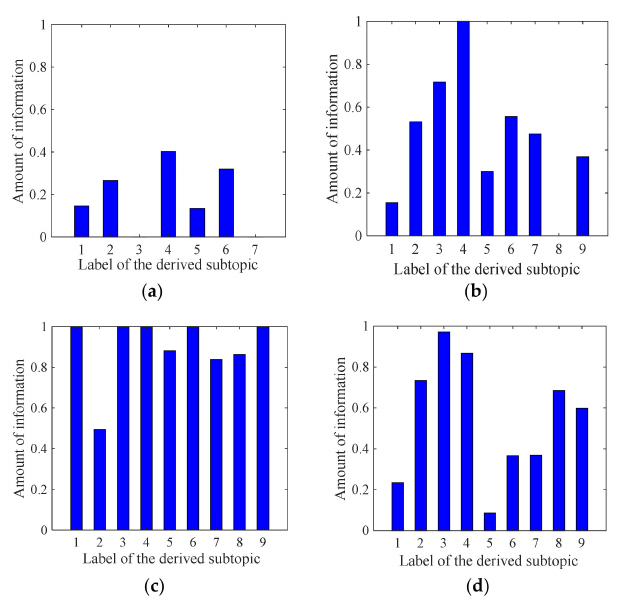
Figure 22. The amount of information of each subtopic under different distributions.